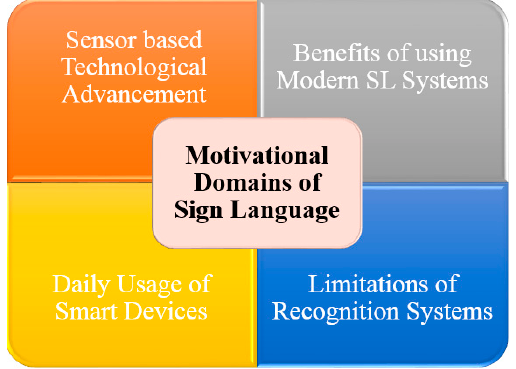
Figure 17. Motivational domains of sign Language.